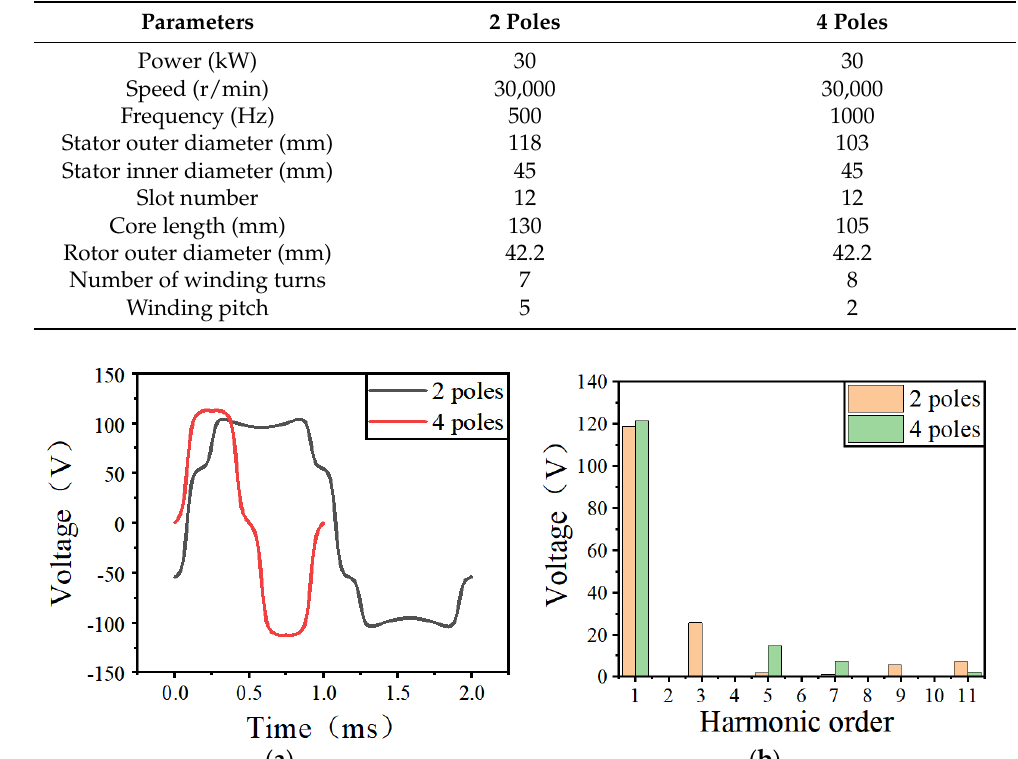
Table 2. Structural parameters of 2 and 4 poles HSPMMs.